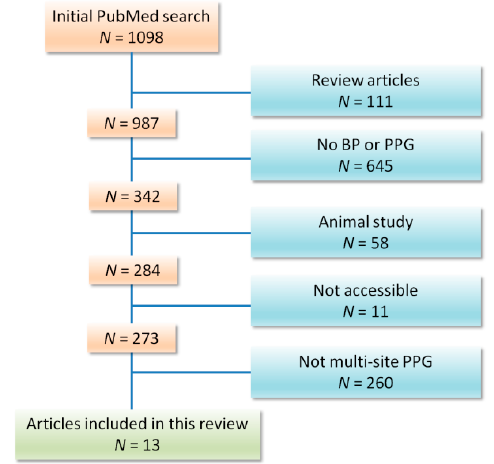
Figure 3. Flow chart of included studies. Thirteen studies could be included out of 1098 articles published between January 2010 and January